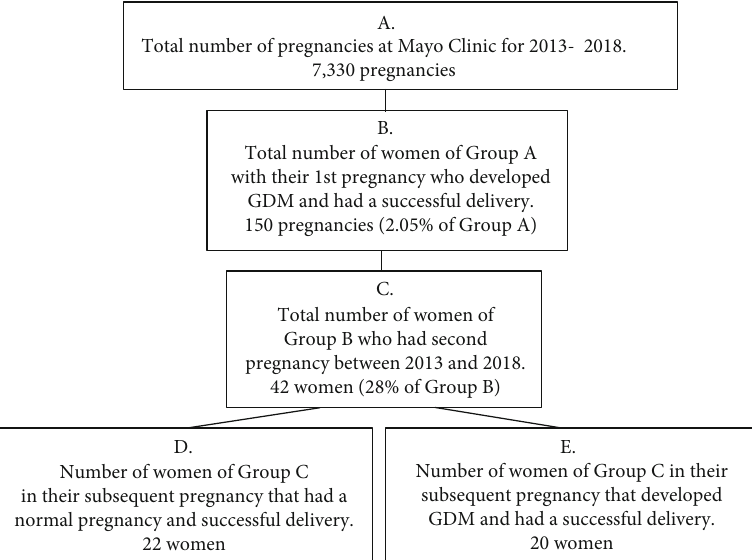
Figure 1: Diagrammatic breakdown of the results of retrograde analysis of women developing GDM in the fi rst and second pregnancies at Mayo Clinic, between 2013 and 2018. As indicated, women who developed GDM in their fi rst pregnancy (Group B) were followed to determine the occurrence (Group E) or lack of occurrence of GDM (Group D) in their second pregnancy in the time frame of the